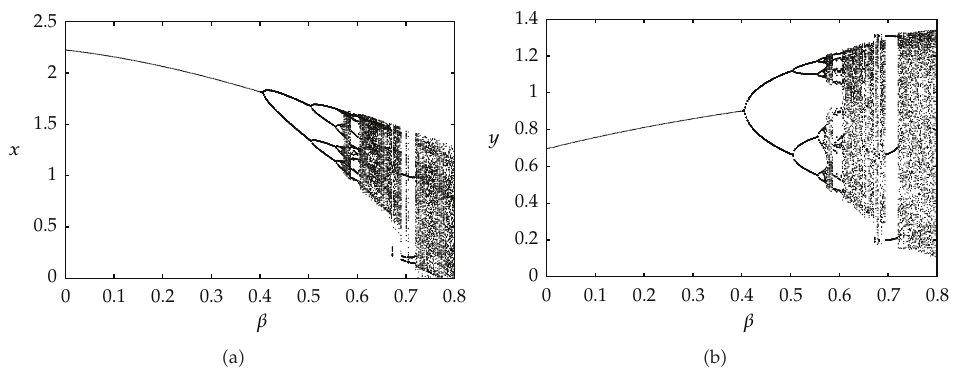
Figure 4: Bifurcation diagrams for the state variable x (cid:2) a (cid:3) and for the state variable y (cid:2) b (cid:3) , varying β . The parameter values are α (cid:7) 0 . 12, σ (cid:7) 1 . 2, γ (cid:7) 0 . 375, ρ (cid:7) 0 . 2, and r (cid:7) 2 . 8.